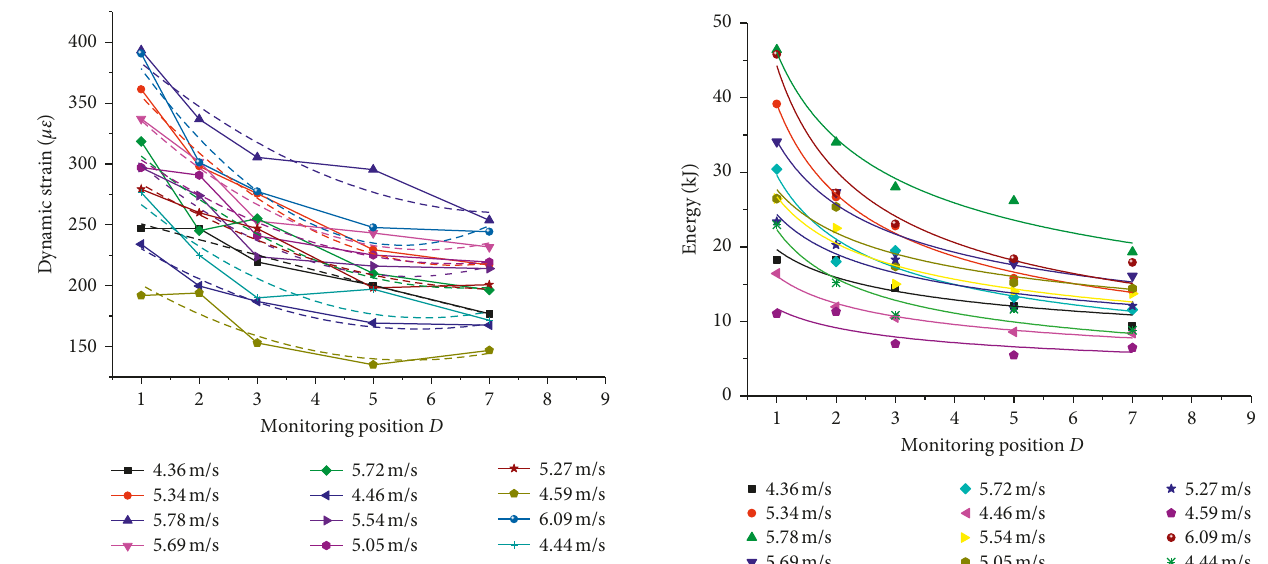
Figure 7: Dynamic strains under different impact velocities.